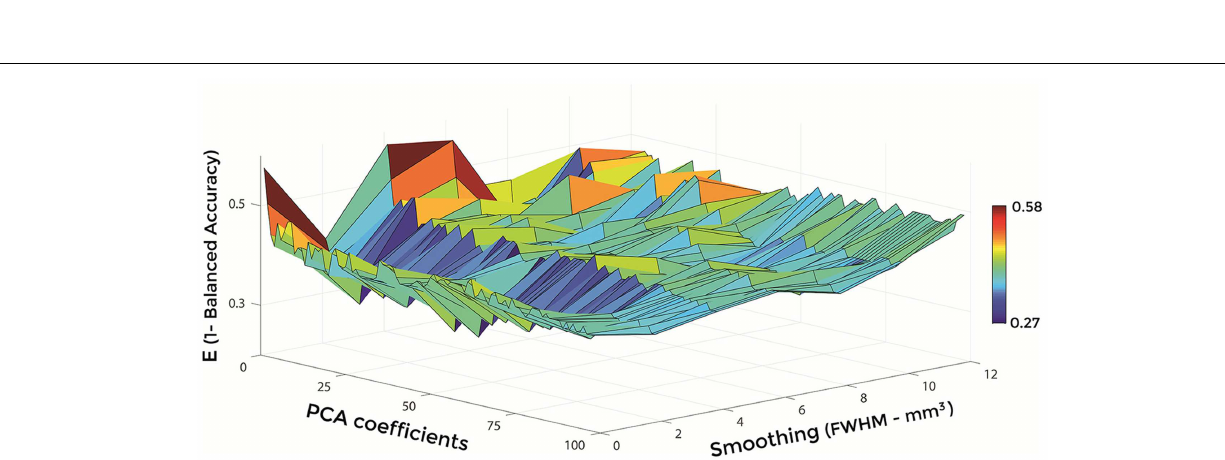
Frontiers in Neuroscience |